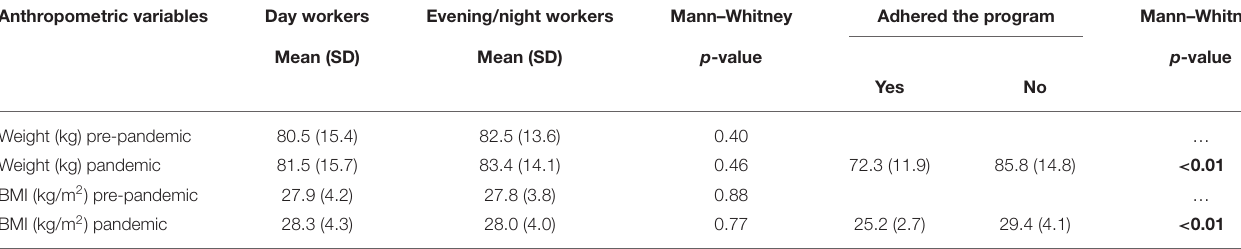
TABLE 2 | Description of anthropometric variables by work shift and adherence to the dietary program. Anthropometric